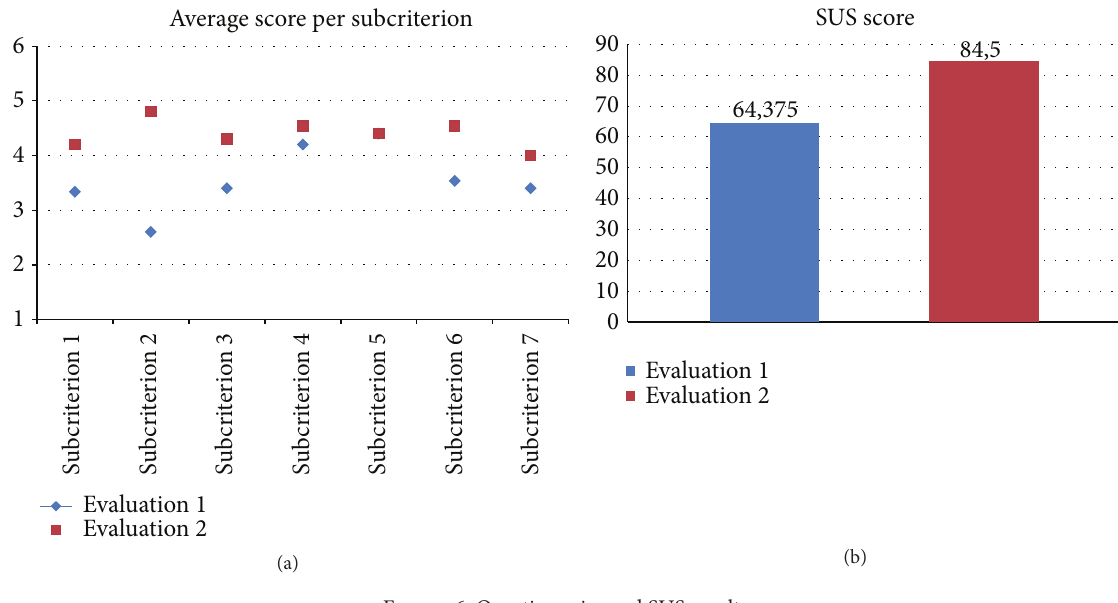
Figure 6: Questionnaire and SUS